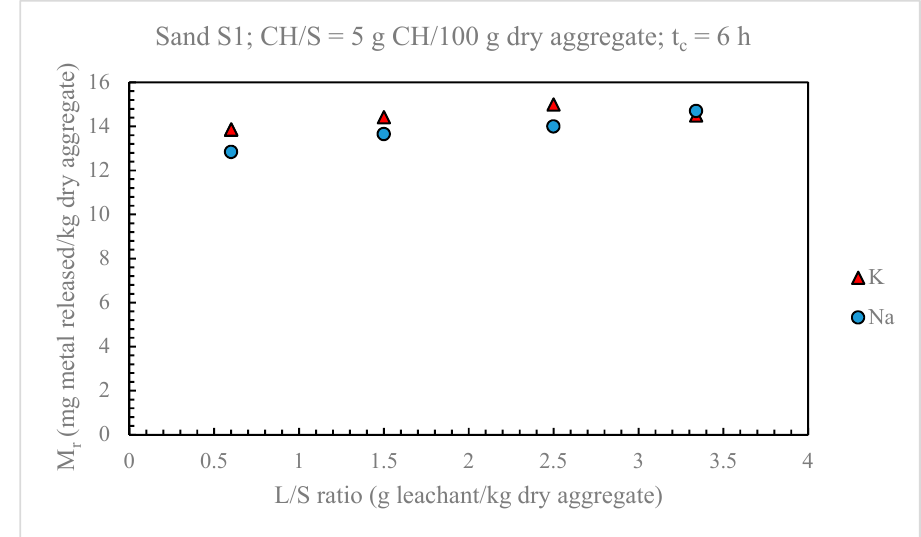
Figure 3. Effect of saturated Ca(OH) 2 solution (leachant) –to-dry aggregate (S) ratio (L/S) on alkaline metal release from sand S1.